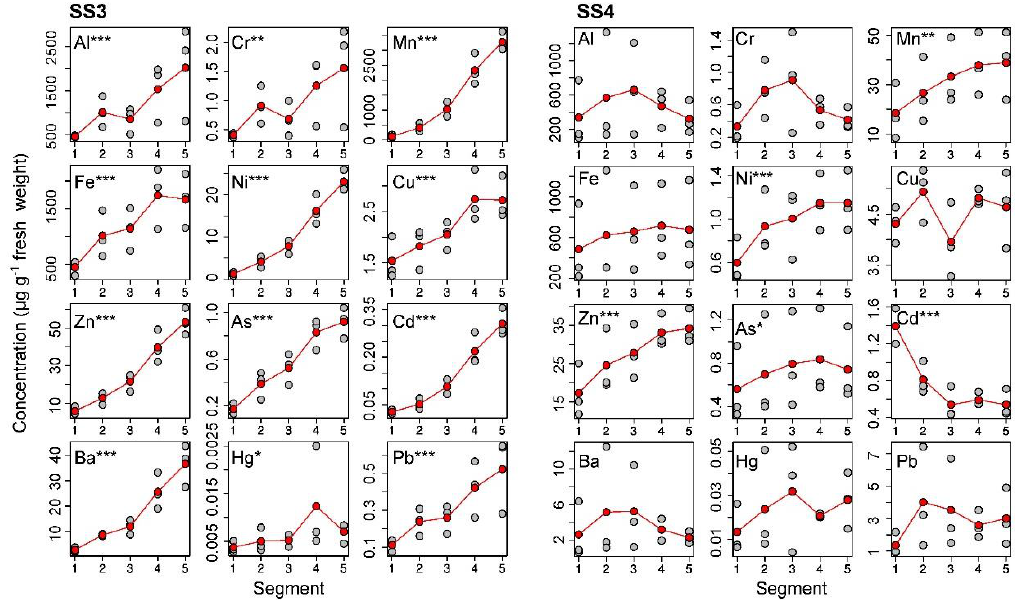
Figure 4. Element concentrations per fresh weight in the shoot segments of each SS. Segments are numbered from 1 to 5, starting at the shoot tip. Symbols as in Figure 3. Asterisks indicate the significance of the Kendall correlation between concentrations and segment number: * p ≤ 0.05; ** p ≤ 0.01; *** p ≤ 0.001.